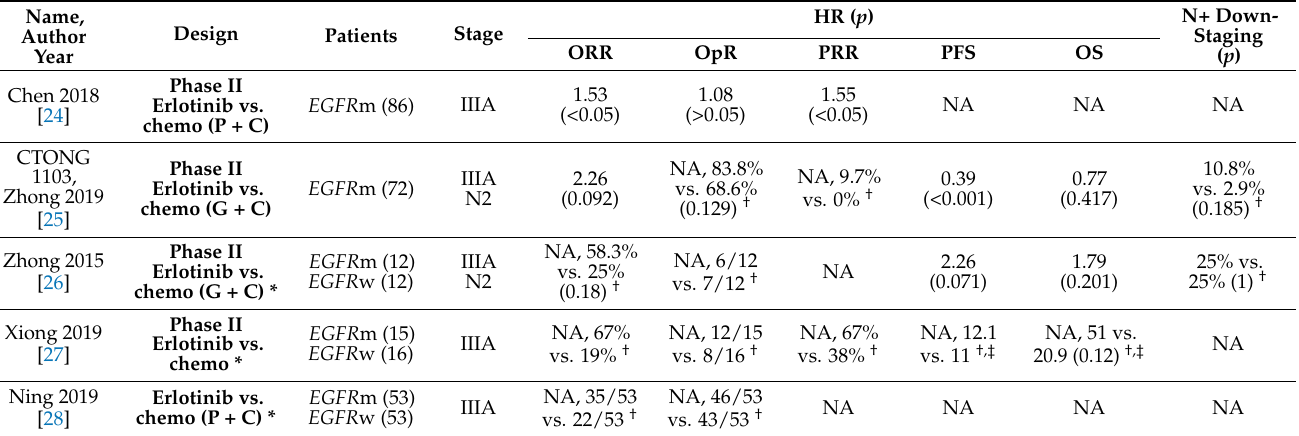
Table 1. Results of trials considering neoadjuvant